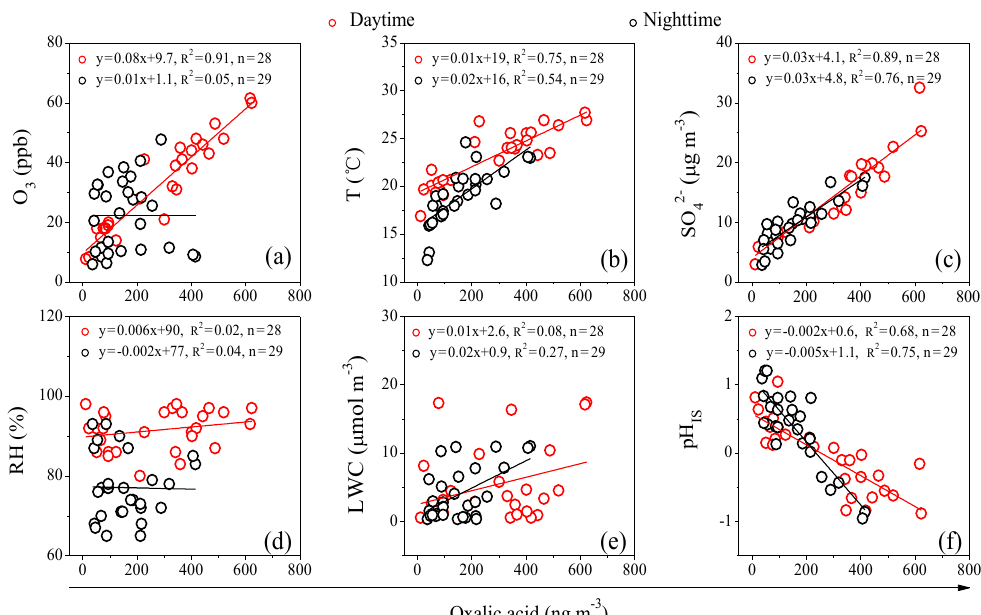
Figure 6. Linear fit regressions of oxalic acid (C 2 ) with (a) O 3 , (b) temperature ( T ), (c) SO 2 − water content (LWC) and (f) in situ acidity of particles (pH IS